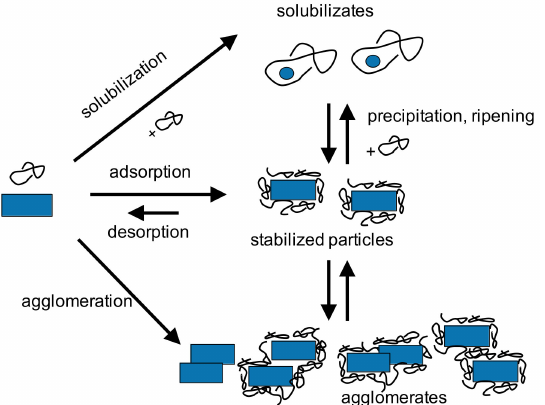
Figure 11. Complex interplay between fracture, surface activation, dissolution, and recrystallization, complex formation, and stabilization.